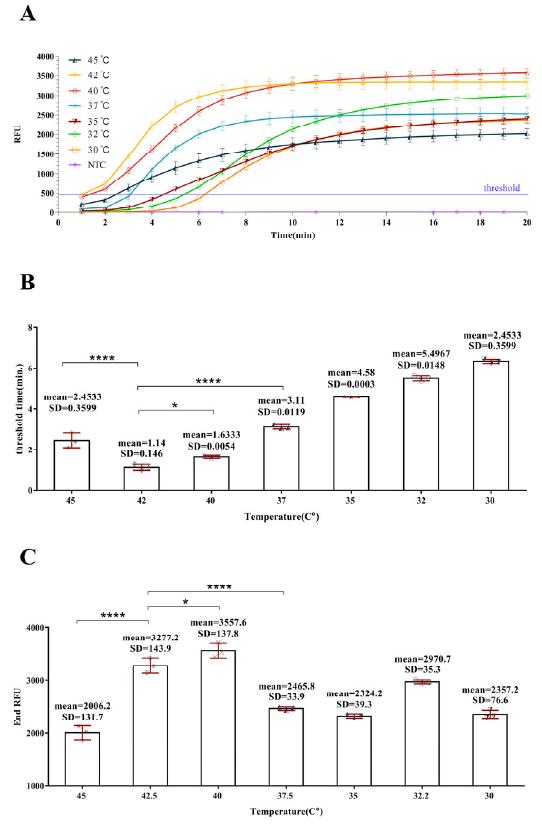
Figure 2. Optimization of reaction temperature. ( A ) Amplification curves of the positive plasmid samples using different temperatures. ( B ) Threshold times of the amplifications using different temperatures. ( C ) End-RFU of the amplifications using different temperatures. SD: standard devia- tion. Compared with each group, significant differences were indicated with asterisks: *, p < 0.05; ****, p <